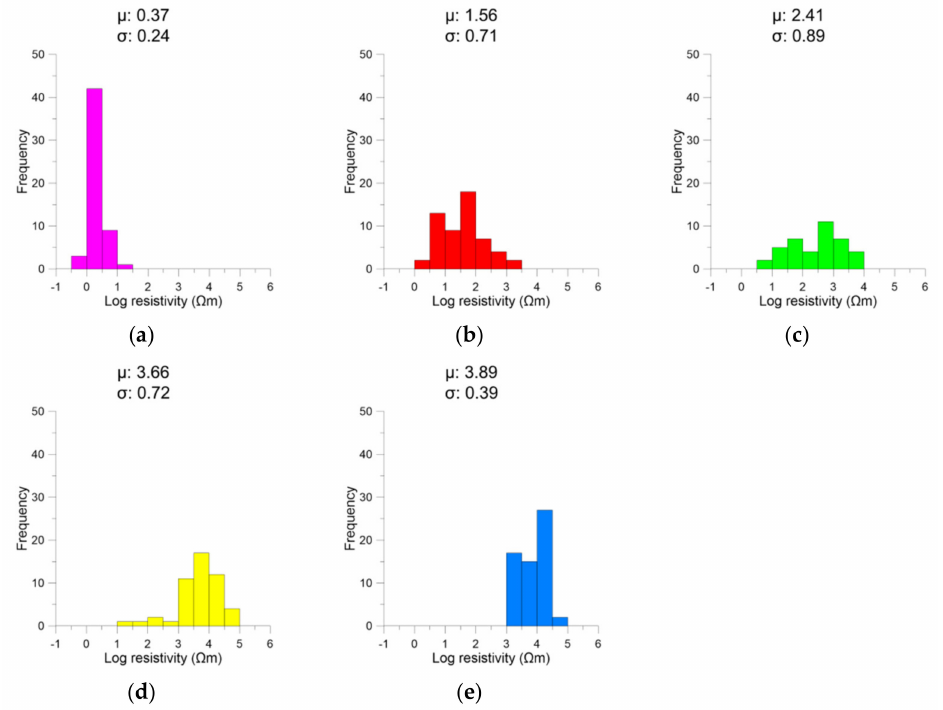
Figure 6. Histograms of logarithmic resistivity of rocks including mean ( µ ) and standard deviation ( σ ) of ( a ) underground ore, ( b ) discovered ore, ( c ) gabbro, ( d ) monzodiorite, and ( e ) quartz